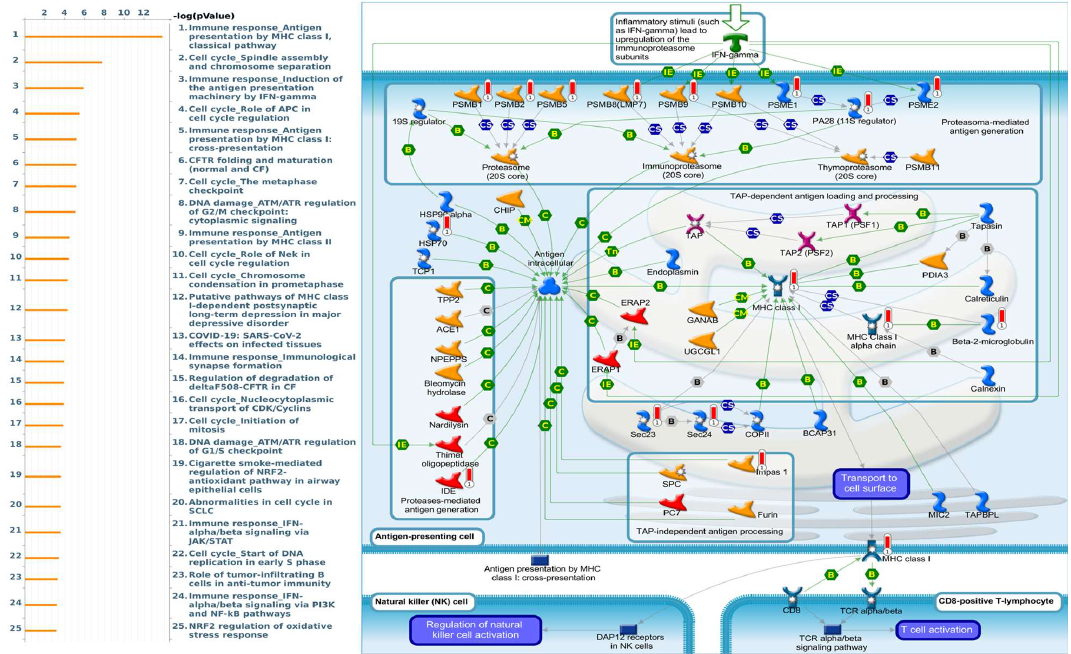
Figure 7. MetaCore pathway analysis of the coexpression gene network of proteasome 20S subunit alpha 3 (PSMA3) in breast cancer patients. We used the MetaCore platform to analyze genes coexpressed with PSMA3 from the associated METABRIC and TCGA datasets, and downstream pathway analyses revealed that “Immune response_Antigen presentation by MHC class I, classical pathway” participates in breast cancer